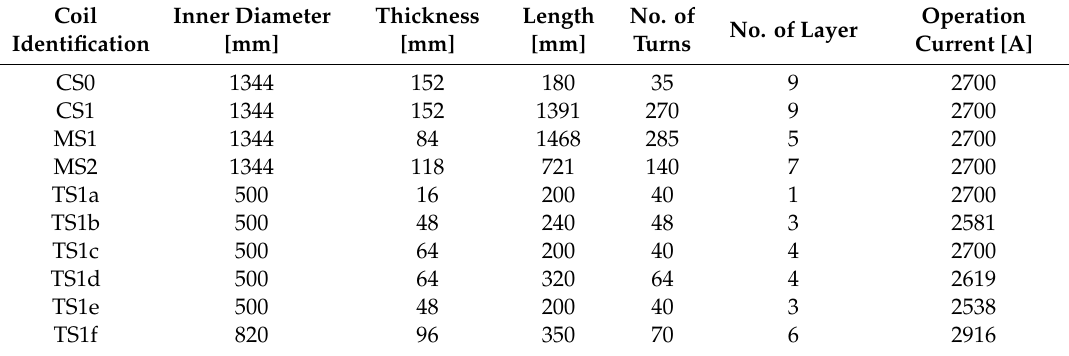
Table 1. The main parameters of the COMET production solenoid